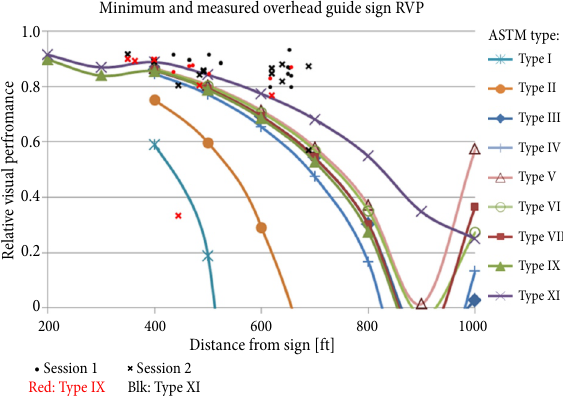
Fig. 5. RVP values corresponding to the measured luminances and distances, compared with the minimum RVP values expected for each ASTM D4956-16 material type (different symbol shapes/colors represent different sessions and sheeting